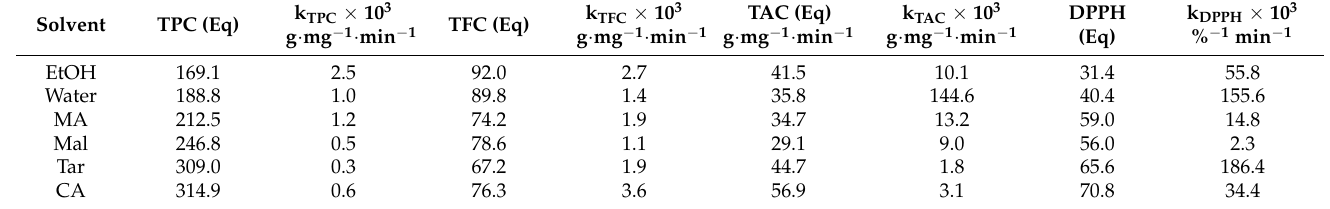
were extracted faster than the polyphenolic compounds. Table 2. Parameters of second-order kinetic model applied for TPC, TFC, TAC, and DPPH; “(Eq)” means “equilibrium values”; k: rate constant.